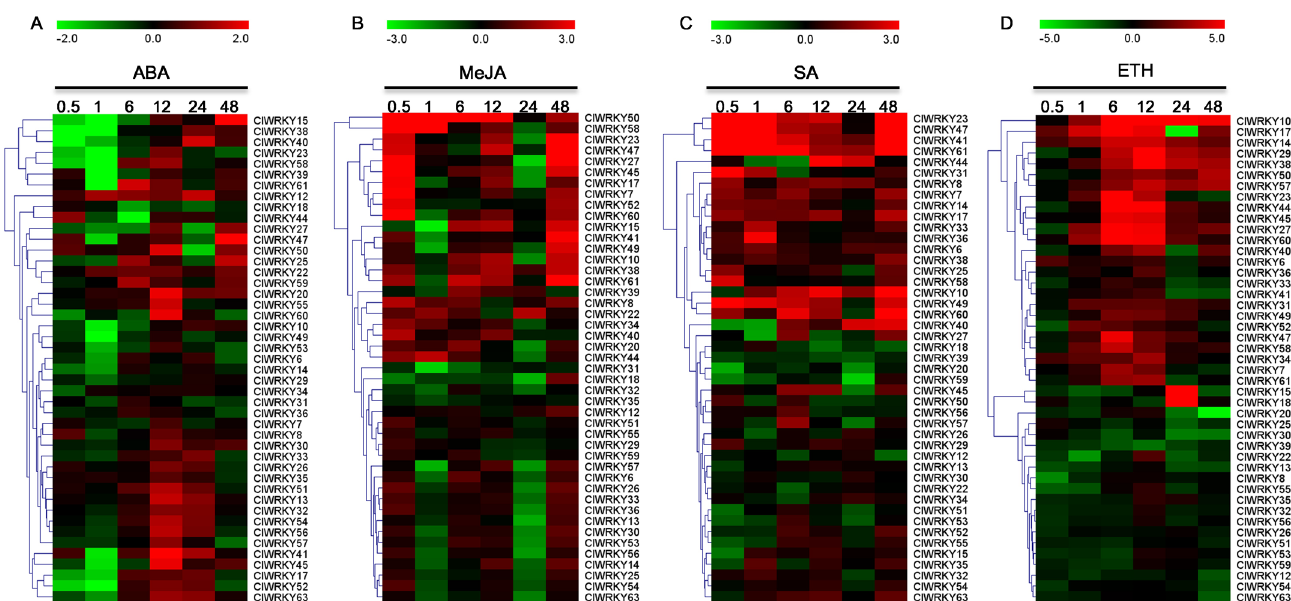
Fig 9. Expression patterns of ClWRKY genes under exogenous hormone treatments. Scale bars on the top of each heat map represent log 2 -transformed (Treatment/Control) values. The hormone treatments including abscisic acid (ABA), methyl jasmonic acid (MeJA), salicylic acid (SA) and ethephon (ETH) are shown as heatmaps (A), (B), (C) and (D), respectively. 0.5, 1, 6, 12, 24 and 48 indicate hours after